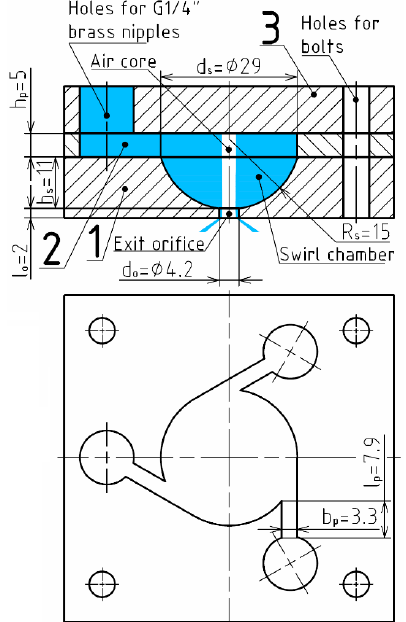
Fig. 1. Ten times enlarged model of the transparent atomizer. Dimensions are in millimetres.